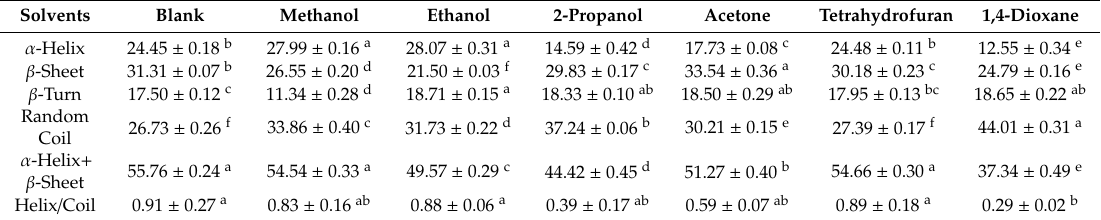
Table 1. Secondary structure content of epoxy-terminated polydimethylsiloxane (PDMS-E) grafted gelatin (PGG) after PGG solution was mixed with six organic solvents (PGG solution/solvent v/v = 1:1). Results are mean ± standard deviations of duplicate analysis. Values followed by different letters in the same line are significantly different ( p ≤ 0.05, N = 3).